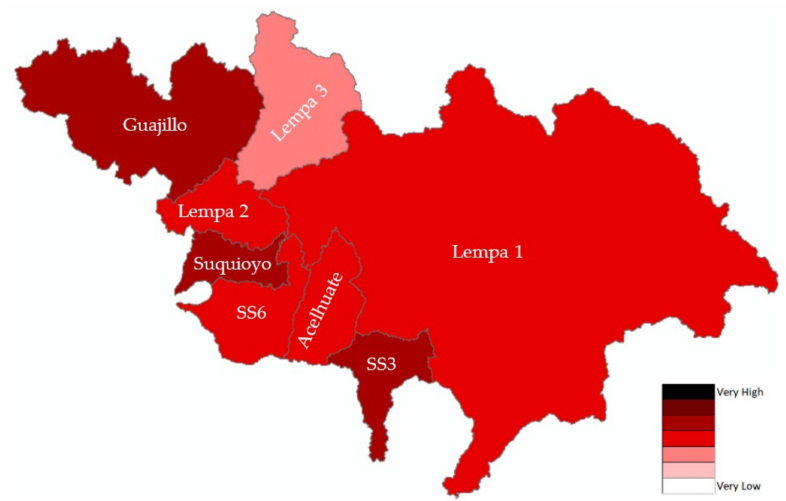
Figure 13. Spatial variation of drought risk index (DRI) in eight sub-basins of Lempa River basin based on SEDI06 (2006–2010).